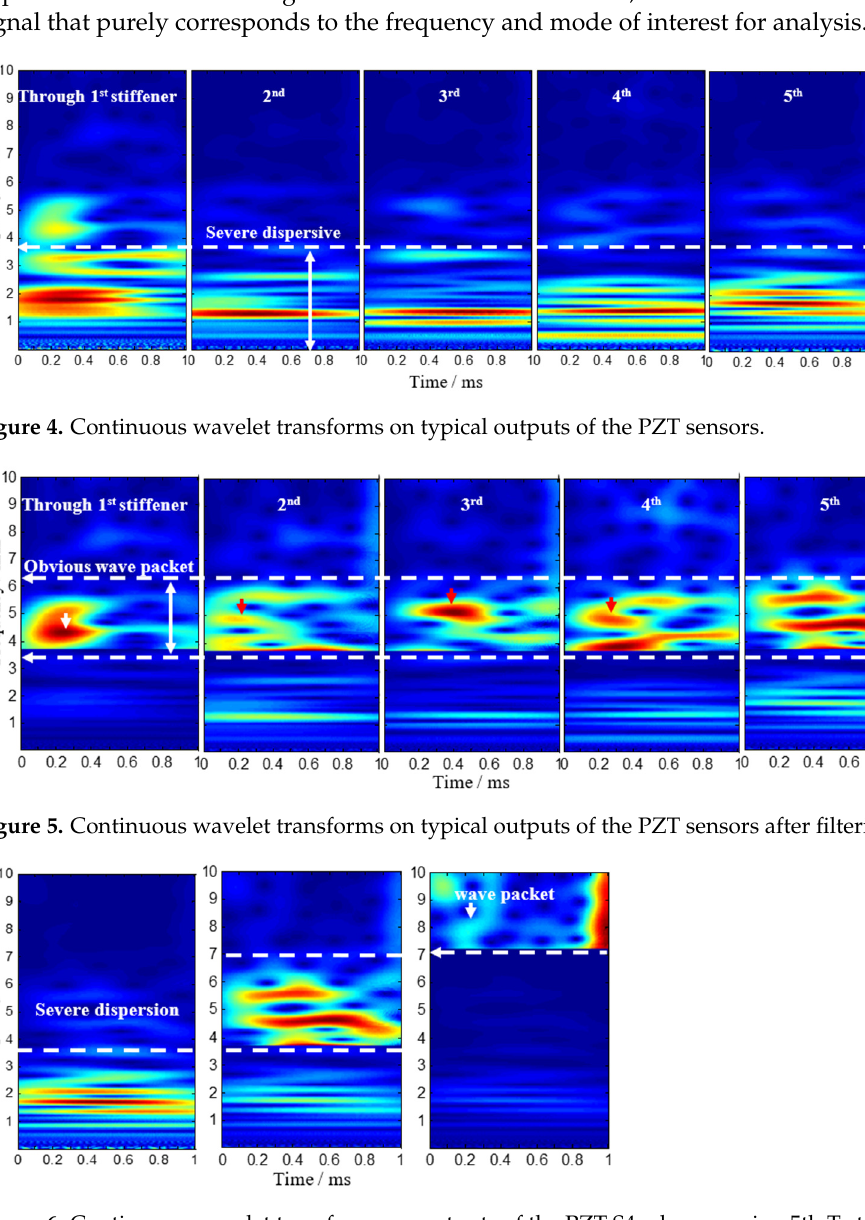
Figure 6. Continuous wavelet transforms on outputs of the PZT S4 when crossing 5th T-stiffeners.